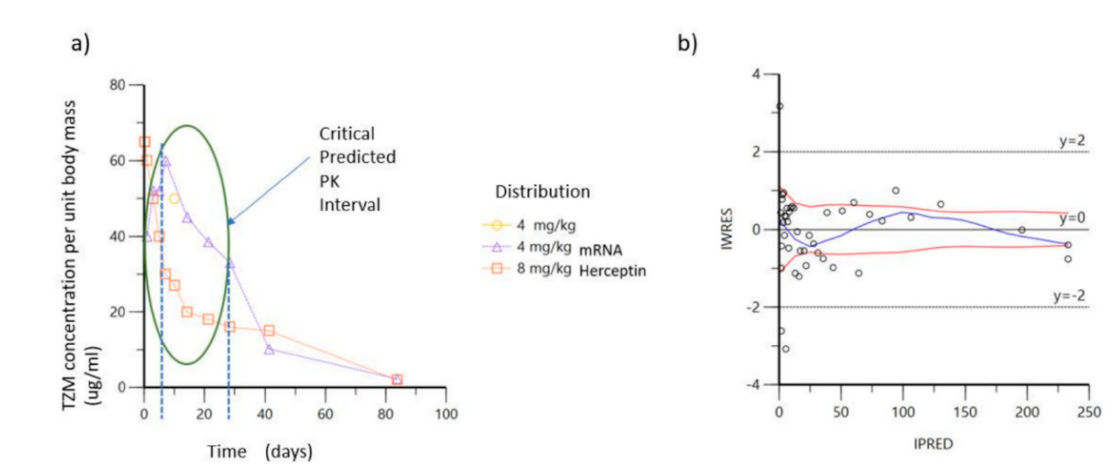
Figure 3. Concentration curves of TZM over time after intra venous infusion: ( a ) Predicted critical time window of interest based on projections of bibliographic data; ( b ) IWRES versus IPRED for predicted data of mAb infusion as full-length protein.